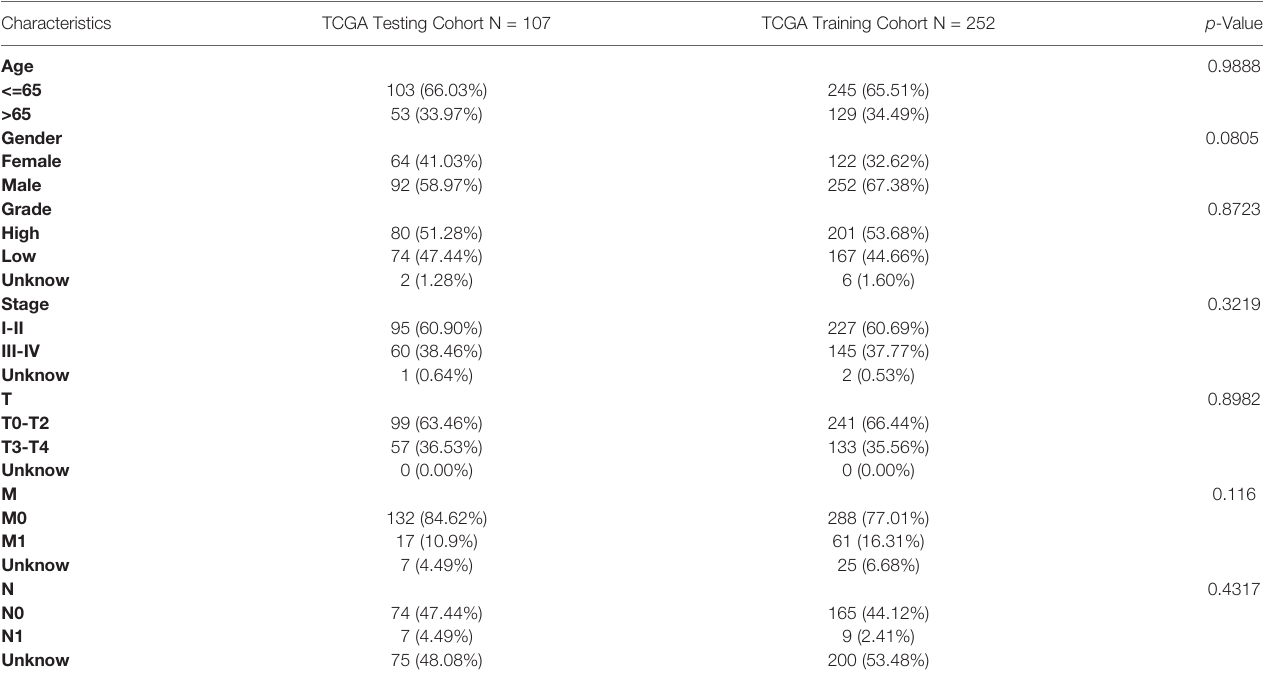
TABLE 2 | Comparison of TCGA training and testing